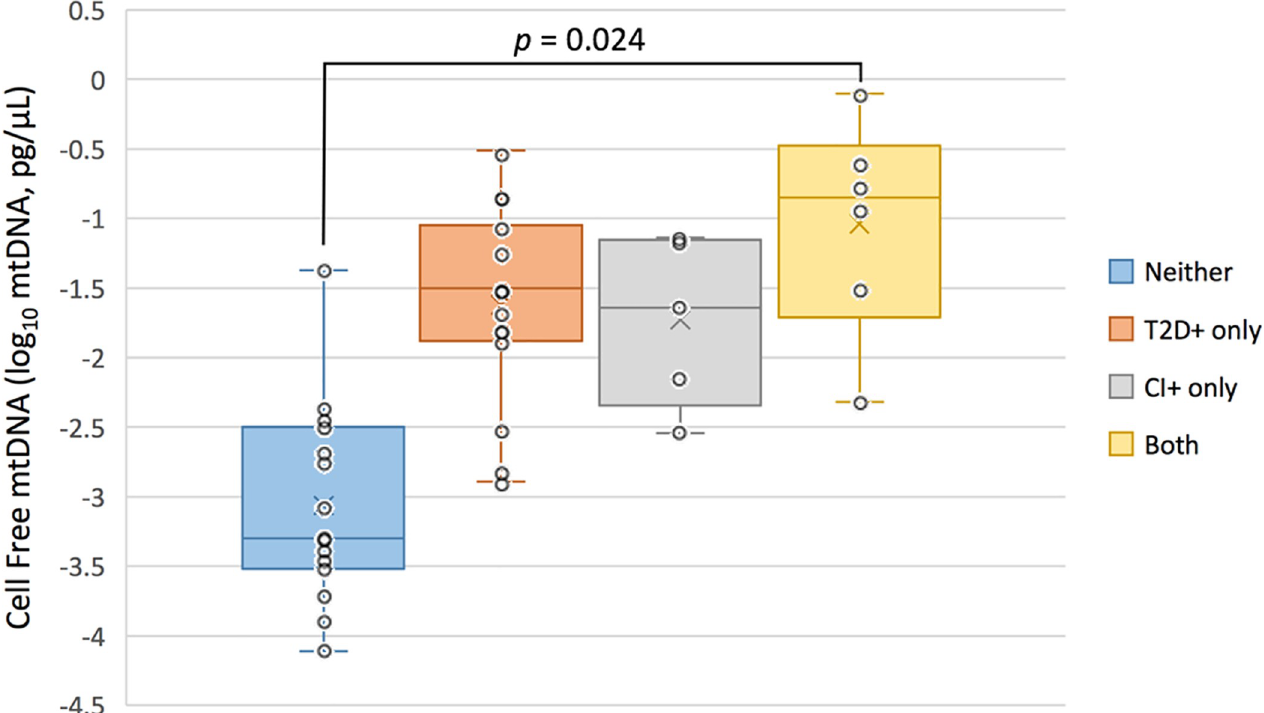
Fig 2. Average cell-free mitochondrial DNA levels stratified by condition. Cell-free mitochondrial DNA levels appear to be significantly higher in individuals suffering from both diseases (T2D and CI) when compared to controls (ANOVA, p-value 0.037, with significant Tukey post-hoc p-value = 0.024 as shown; respective Shapiro-Wilk test for normality, p-values = 0.521, 0.459, 0.443, 0.772).